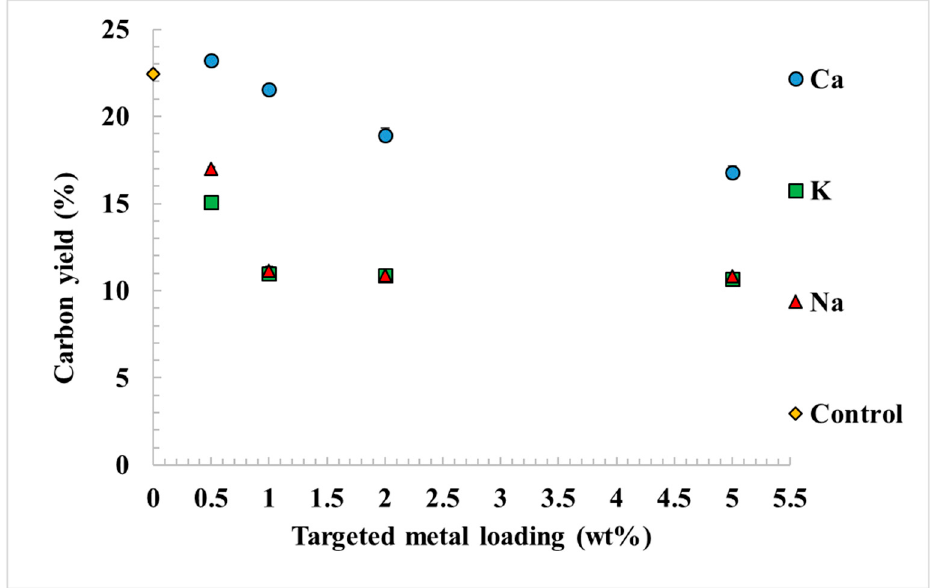
Figure 3. Total carbon yield from in-situ catalytic fast pyrolysis (CFP) experiments with H + ZSM-5 catalysts deactivated by inorganics.